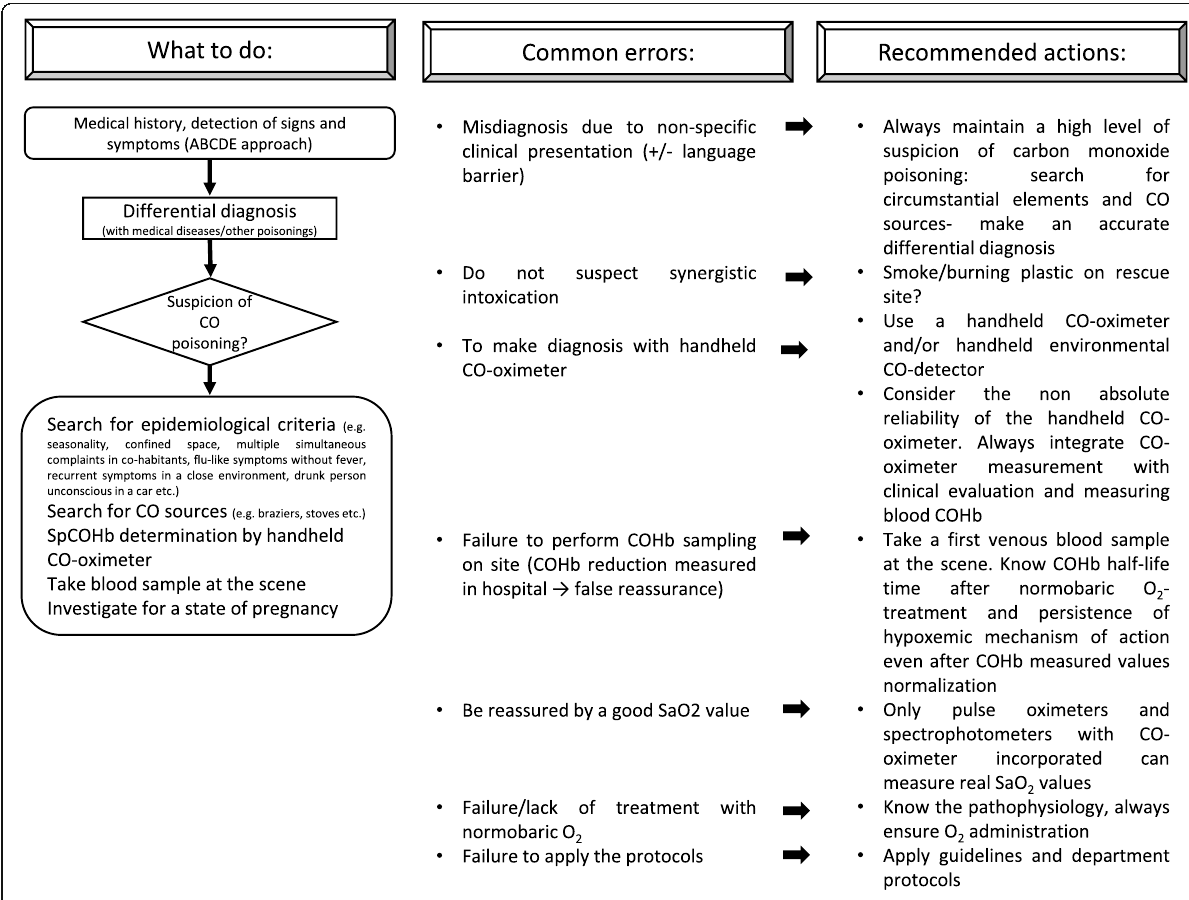
Fig. 3 Practical tips for out-of-hospital management of carbon monoxide